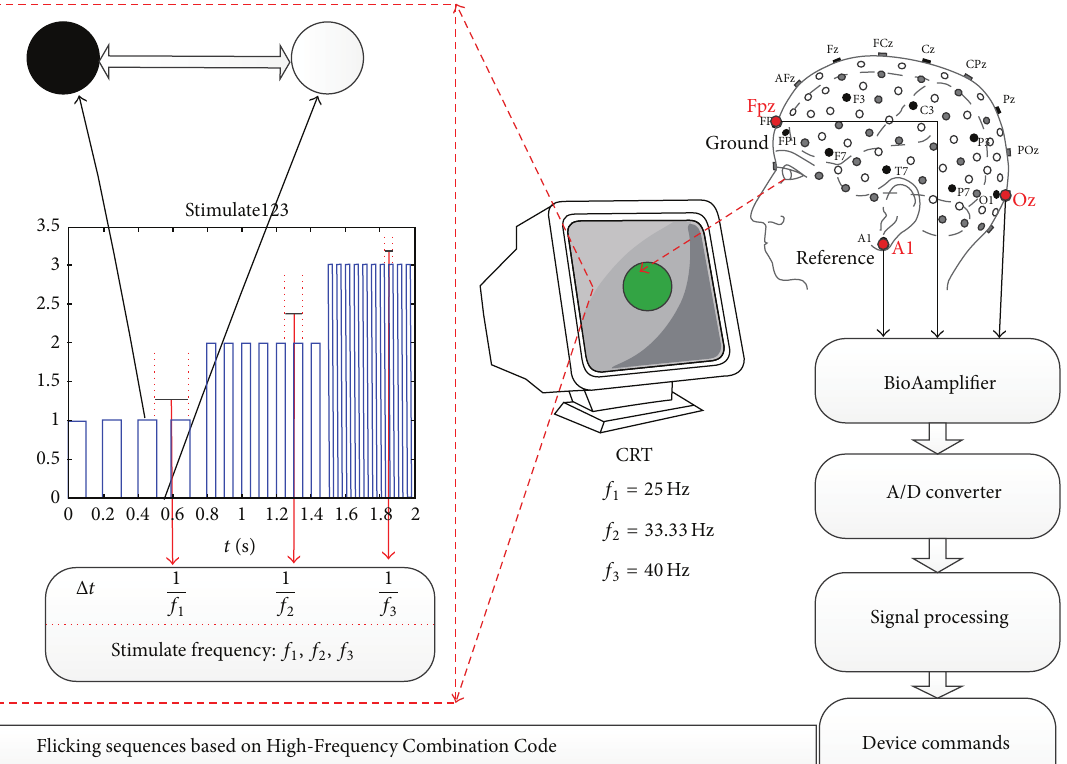
Figure 1: Block diagram of a TSCCBH-SSVEP for